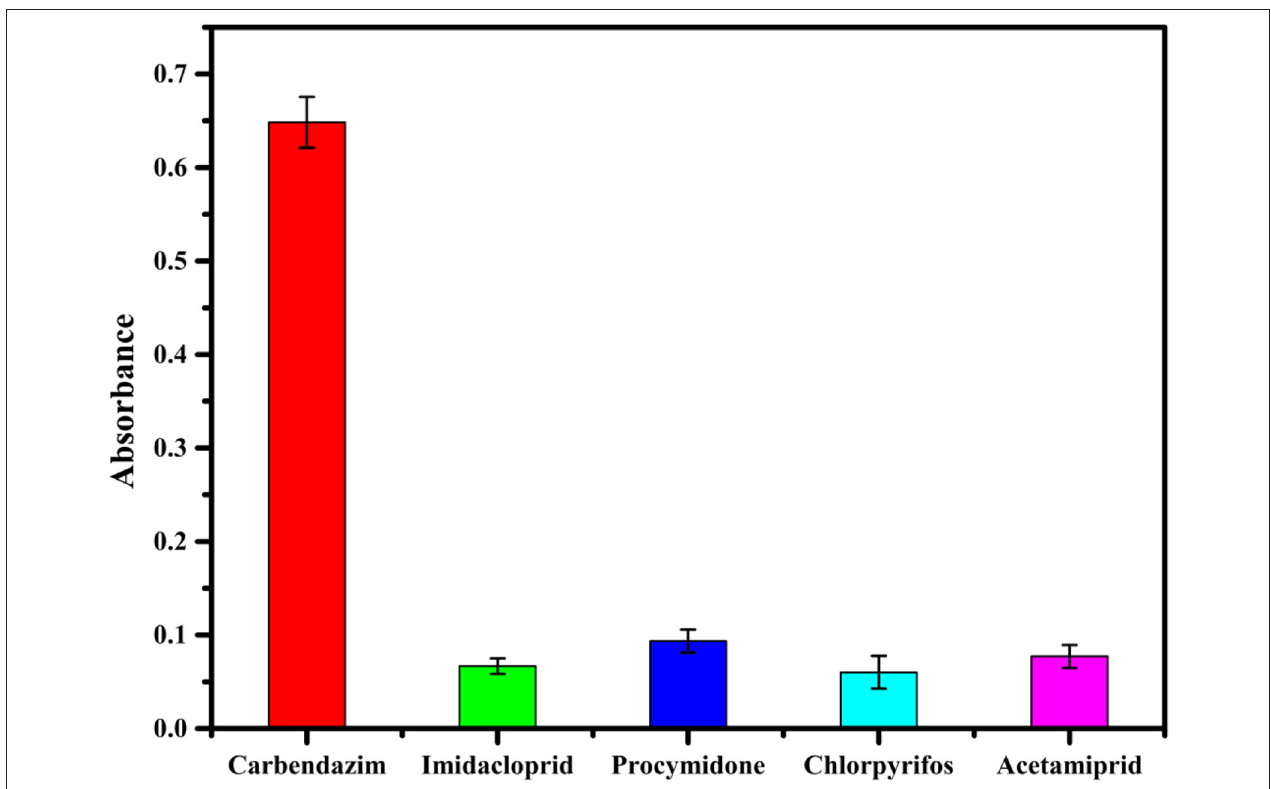
FIGURE 5 | Specificity between CBZ and other unrelated